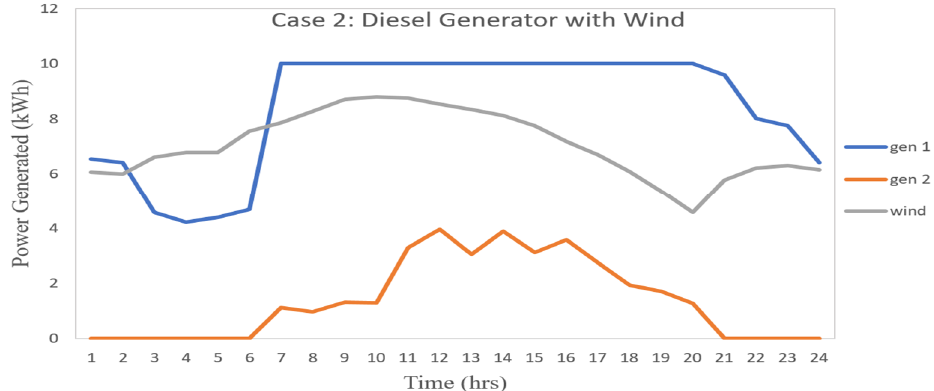
Figure 5. Case 2: Power output variation from diesel and wind turbine generators.